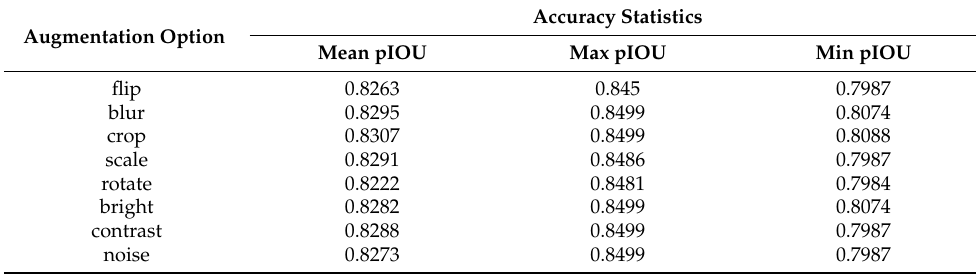
Table 3. Accuracy of deep learning models using different data augmentation options. Table shows the mean, max, and min pIOU of validation